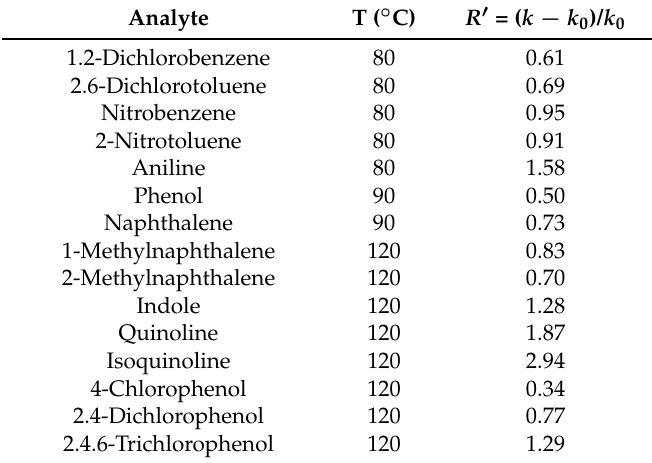
Table 4. Retention-increments R’ for the selective interaction of aromatic compounds with C 60 . Complexation column ( k ): 10 m x 0.25 mm I.D. fused silica column coated with the C 60